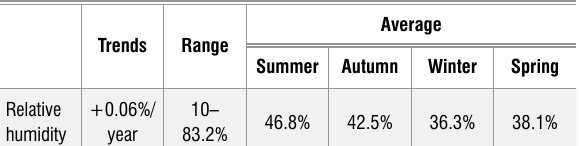
Relative humidity seasonal means for northernmost Limpopo Province, 1950–2016 Trends Range